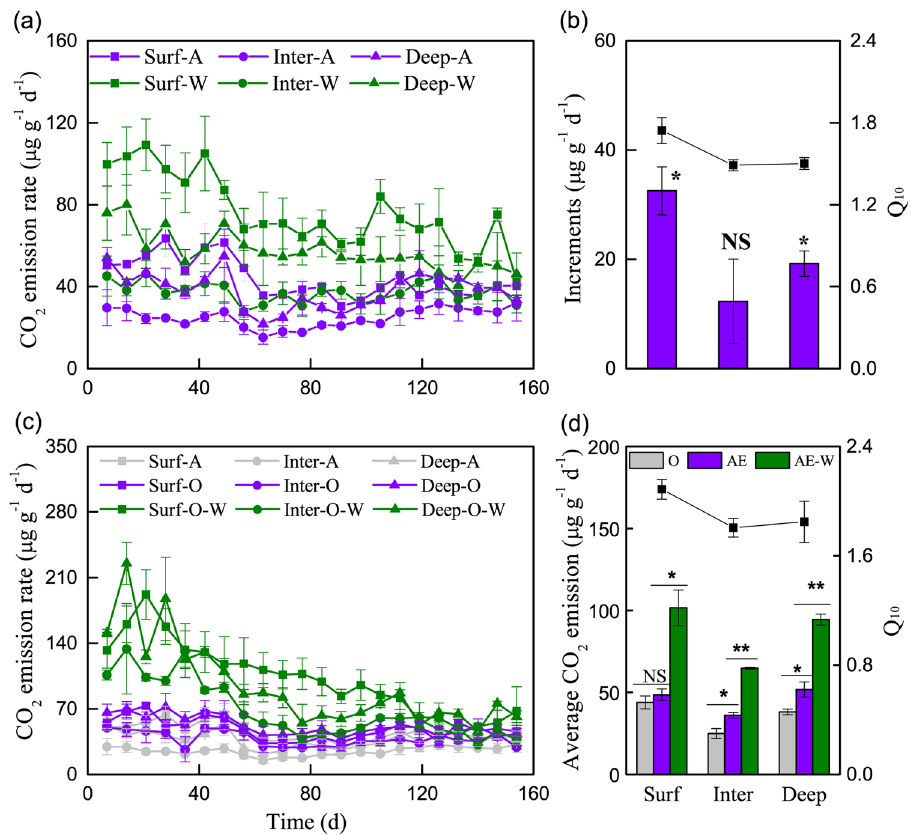
Fig. 5 Comparison of CO 2 emission rate from the three water table-dependent soil layers under different oxygen and temperature conditions. a , c Emission during 154 days of incubation under anoxic and oxic conditions. b Increases in CO 2 emission as a result of warming and the Q 10 of CO 2 emission under anoxic conditions. Absolute increases are shown on the left vertical axis, while Q 10 values are plotted on the right vertical axis. Increases were assessed for signi fi cance using the t -test. d Differences in emission depending on the oxygen conditions and temperature, and the Q 10 of CO 2 emission under oxic conditions. Absolute rates are plotted on the left vertical axis and Q 10 values on the right vertical axis. (Paired t -test. * p < 0.05, ** p < 0.01; NS no signi fi cant difference). Surf surface, Inter interlayer, A anoxic conditions, O oxic conditions, W warming.